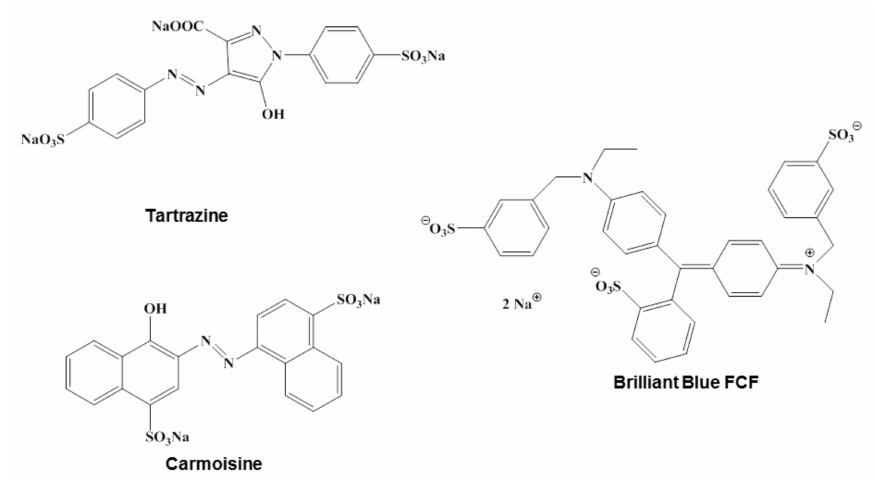
Figure 1. The chemical structures of investigated